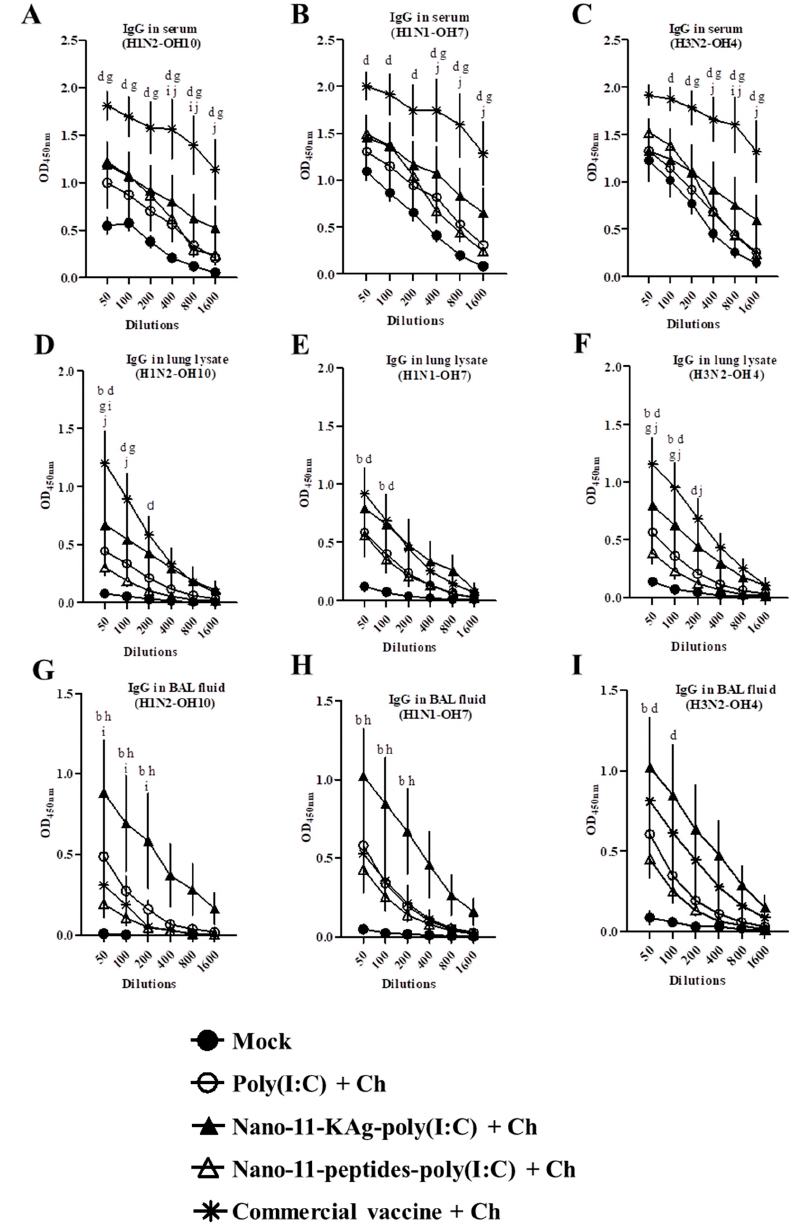
Figure 3. Commercial influenza vaccine augmented systemic IgG response and Nano-11-KAg-poly(I:C) vaccine in lower respiratory tract. Pigs were vaccinated twice with poly(I:C) adjuvanted Nano-11-based vaccines (containing H1N2-OH10 virus or 10 peptides) or commercial vaccine (containing H1N1, H1N2 and H3N2 viruses) and challenged (H1N1-OH7 virus) at 35 days post prime vaccination. Samples collected at day six post-challenge were used for IgG antibody analysis. The IgG antibody response in serum, lung lysate, and BAL fluid samples against ( A , D , G ) H1N2-OH10; ( B , E , H ) H1N1-OH7; and ( C , F , I ) H3N2-OH4 viruses were analyzed by ELISA. Data represent the mean value of four to five pigs ± SEM at all indicated dilutions. Statistical analysis was carried out using two-way ANOVA followed by a Bonferroni test. Each letter indicates the significant di ff erence between the groups at the indicated dilution. b and d indicate the di ff erence between mock group compared to Nano-11-KAg-poly(I:C) + Ch, and Commercial vaccine + Ch, respectively. g indicate the di ff erence between poly(I:C) + Ch compared to Commercial vaccine + Ch. h and i indicate the di ff erence between Nano-11-KAg-poly(I:C) + Ch compared to Nano-11-peptide-poly(I:C) + Ch and Commercial vaccine + Ch, respectively. j indicates di ff erence between Nano-11-peptide-poly(I:C) + Ch) compared to Commercial vaccine + Ch. A p < 0.05 was considered statistically significant.